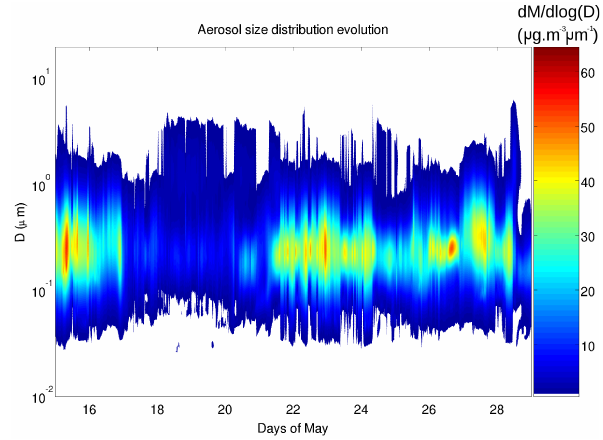
Fig. 8. Evolution of aerosol chemical composition from AMS+MAAP and mass integrated from the SMPS and APS in µgm − 3 during the fourteen days of measurement.